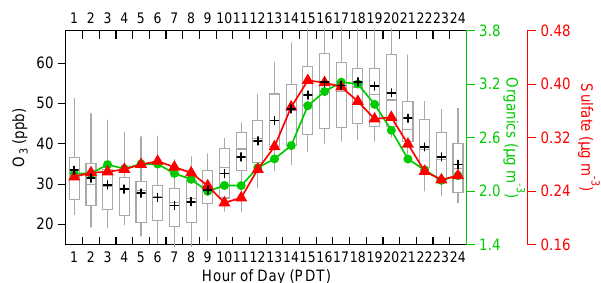
Fig. 8. Diurnal patterns of O 3 , organics and sulfate. Box plots for O 3 : whiskers correspond to the 10th and 90th percentile, boxes to the 25th and 75th percentile, the horizontal marks in the boxes to the median, and the black crosses to the mean. Data for organics and sulfate correspond to the mean.